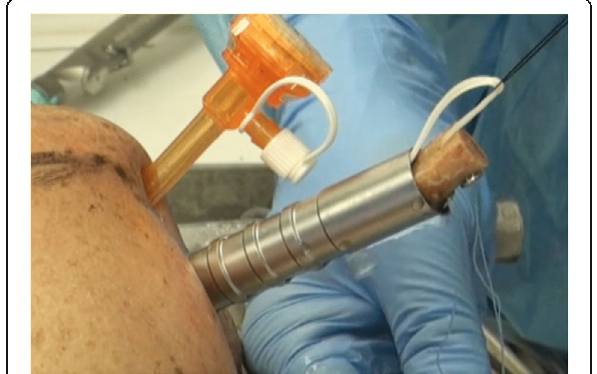
Fig. 5 Left shoulder, view from anterior, metal cannula in antero-inferior portal, arthroscopic cannula in antero-superior portal. The graft passed through the metal cannula